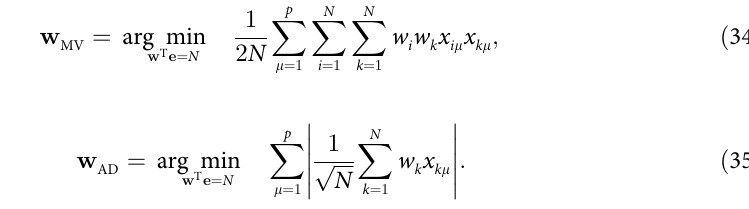
S1 Data. Figure 1 and figure 2 from S1 Data. S1 Data is the result from numerical experiment of S1 File and S2